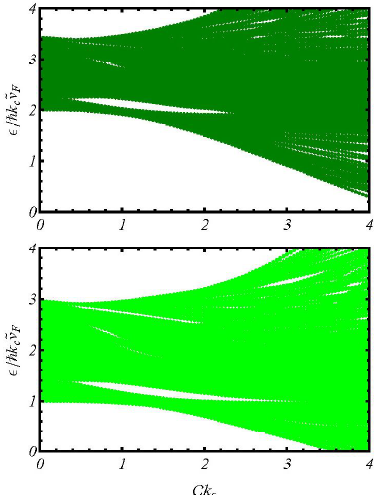
Figure 3. (Color online) Minigap spectrum ε ( k ) / ( (cid:126) ˜ v potential, as a function of the normalized modulation amplitude C k two plots correspond to the two lowest values of the quantized transverse wave number k ( m ) The graph at the top comes from the lowest quantized energy subband, whereas the graph at the bottom is due to the first-excited